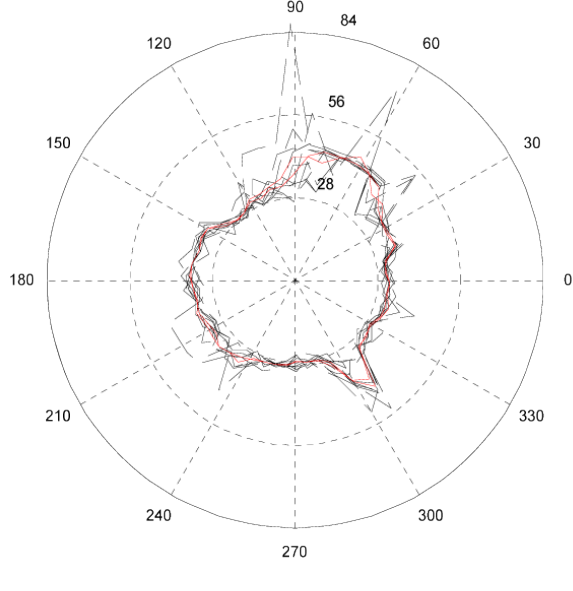
Figure 3. Polar plots for the raw data for ocular ACA for all meridians and the resulting means and medians for the meas- ured meridians for three subjects are provided. For each subject, there are 10 polar profiles (the dashed black profiles) that rep- resent meridional results from 10 consecutive maps determined using the Oculus Pentacam. An additional two red solid profiles for each subject then represents the meridional means and medi- ans respectively as determined from the raw data. a) Subject 1, b) Subject 2 and c) Subject